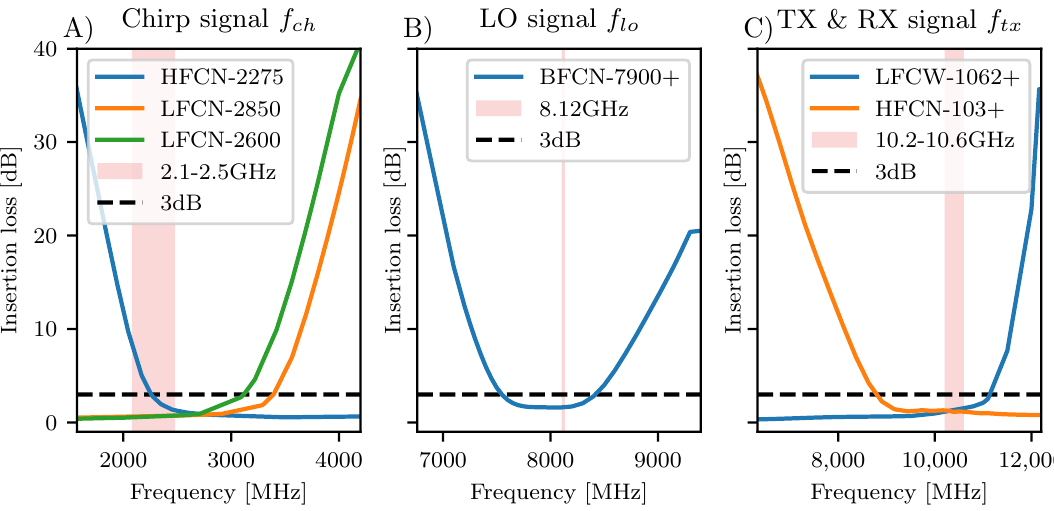
Figure 2. The insertion loss frequency responses of the HF-filter in mGEODAR. Each subplot gives the filter used in the frequency areas of annotated boxes ( A – C ) in Figure 1. Pink area denotes the frequency ranges of the optimized system (see Section 2). Note, the line plots are for single filters and they are cascaded so that their responses accumulate accordingly. Data taken from the manufacturer